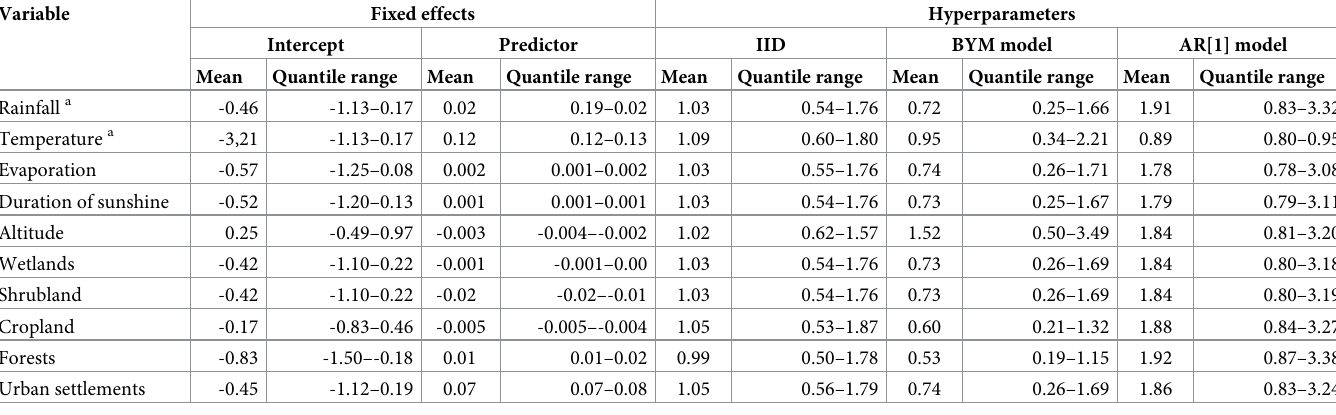
Table 1. Posterior parameter distributions from univariable models used to screen predictor